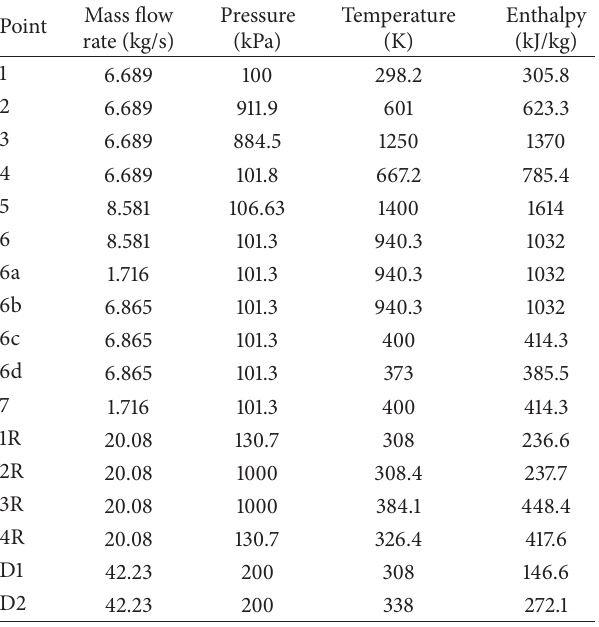
Table 1: Thermodynamic properties of modeled system. Mass Point